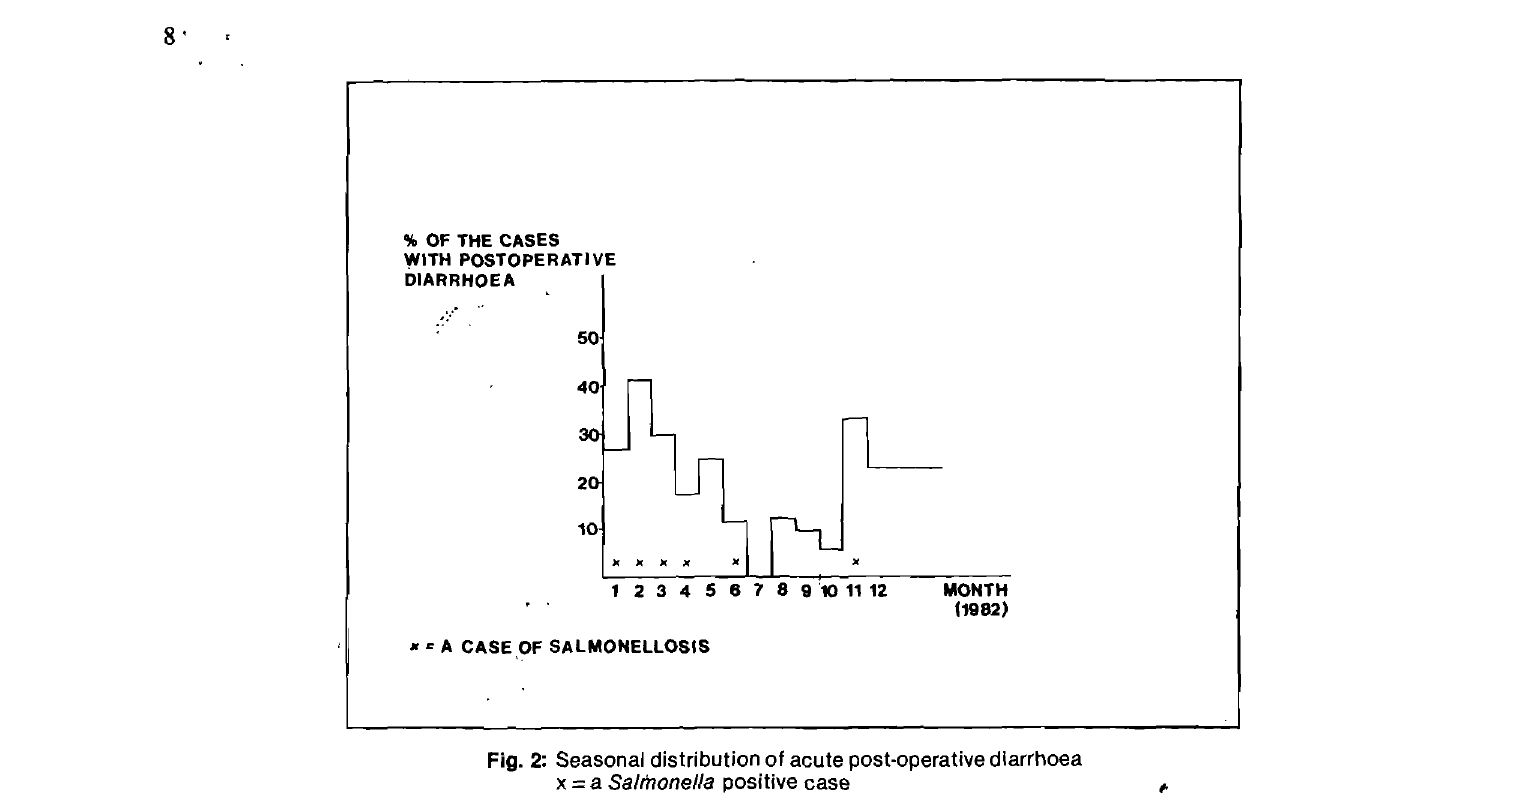
Table 3: Observed causes of death in the non-survived cases of post-operative diarrhoea Cause of death Duration of diarrhoea Time of death Notes (days after operation) (day after operation) Horses recovered from diarrhoea: Cardiac arrest 2-10 14 during 2nd op. Massive intra-abdominal' adherences 4- 6 ;'.-> during 2nd op., E Peritonitis . ;" during 3rd op., E Horses suffering from diarrhoea: Salmonellosis (S.